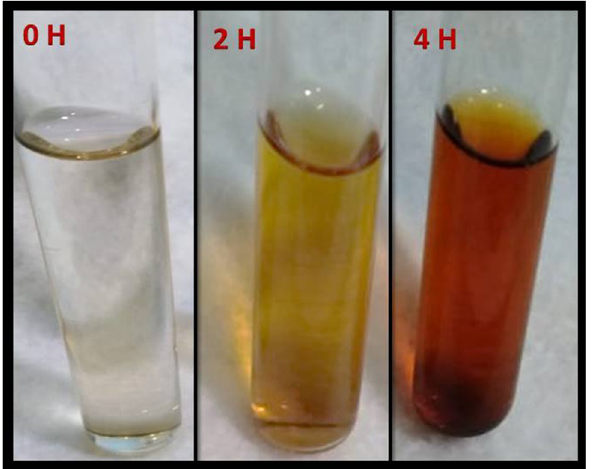
Figure A1: Visual appearance of phytosynthesis solutions that contained 10 mM Na 2 SeO 3 and 1.0% from Saussurea costus extract, after incubation for 0, 2 and 4 h.